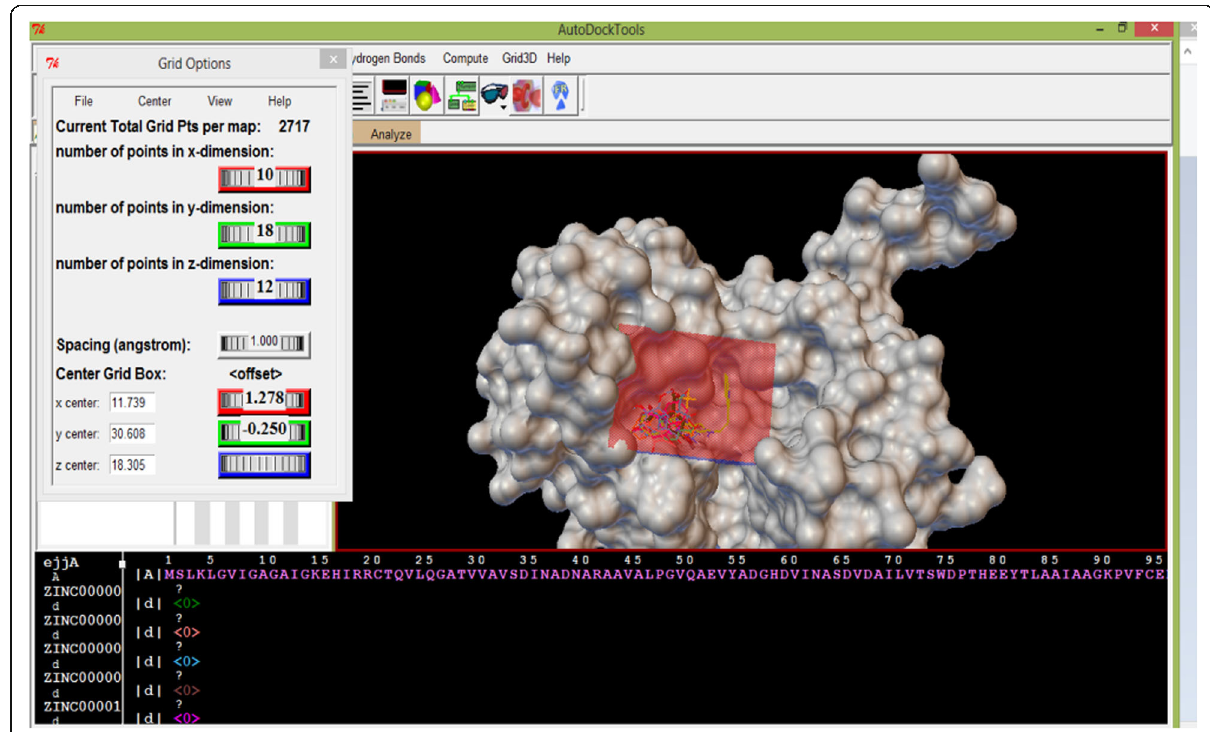
Fig. 6 Docking grid box for the protein model of EJJ83173. The grid box of dimensions x-10, y-18, z-12 and grid center x-11.739, y-30.608, z- 18.306 was set using AutodockTools 1.5.6 software. The colored projections in the center represent the active